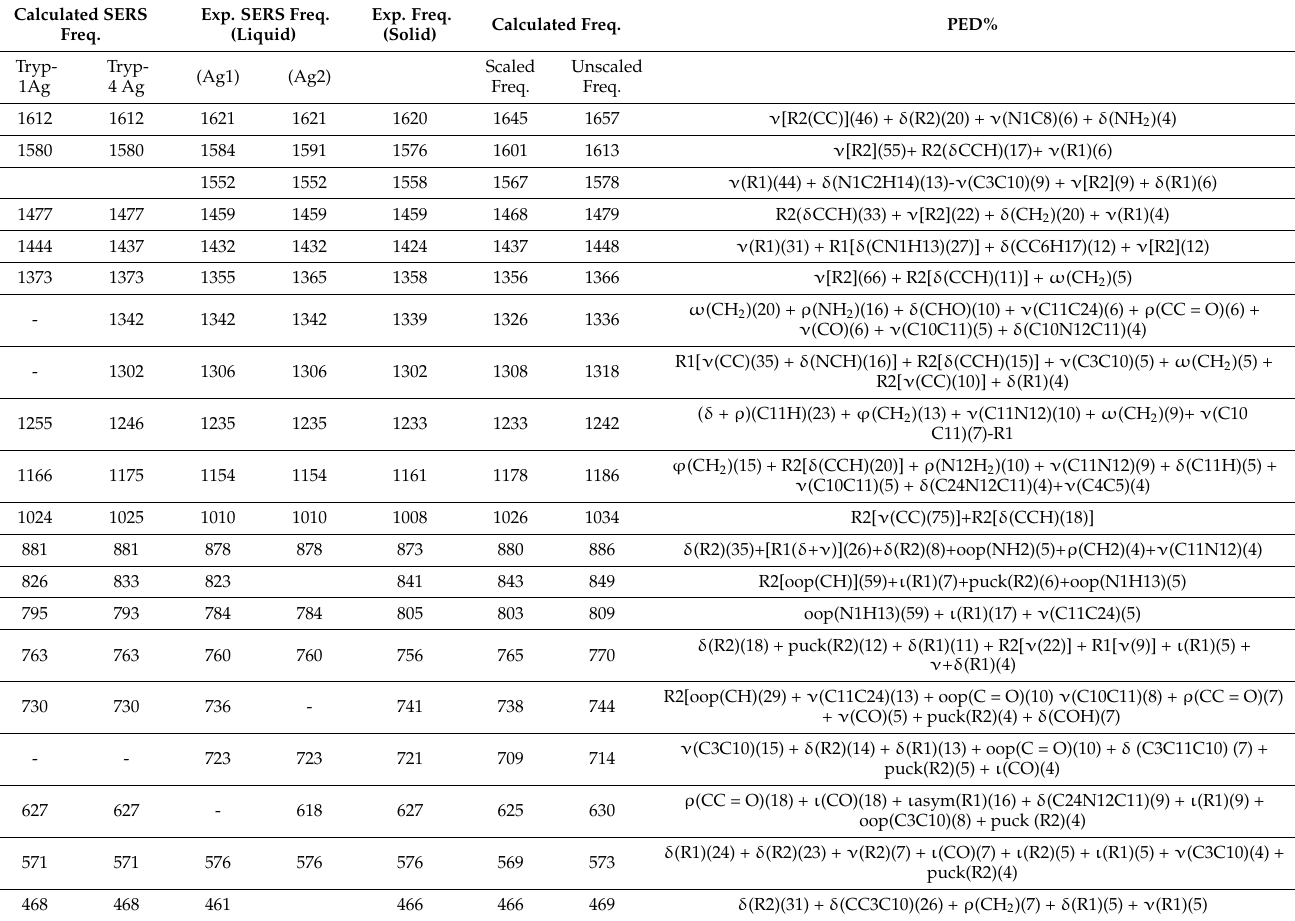
Table A1. Vibrational assignments for experimental and calculated wavenumber of L-tryptophan.